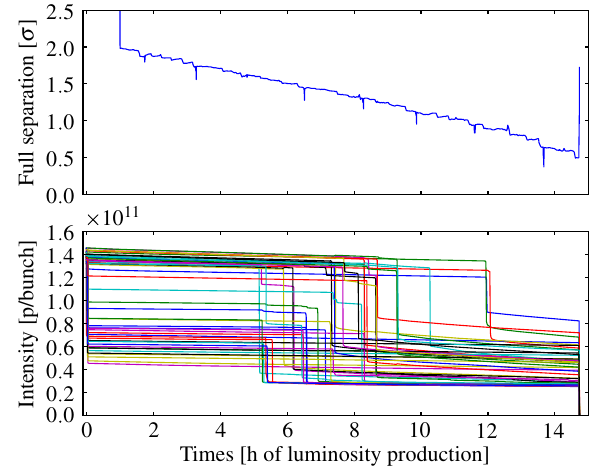
FIG. 14. Above, separation between the beams at the IP during luminosity leveling with a transverse offset in IP8, derived from measured luminosity in IP1,5 and 8, expressed in unit of the transverse beam size. Below, the intensity of the 49 bunches colliding only in IP8, the other 1331 bunches follow a standard quasiexponential